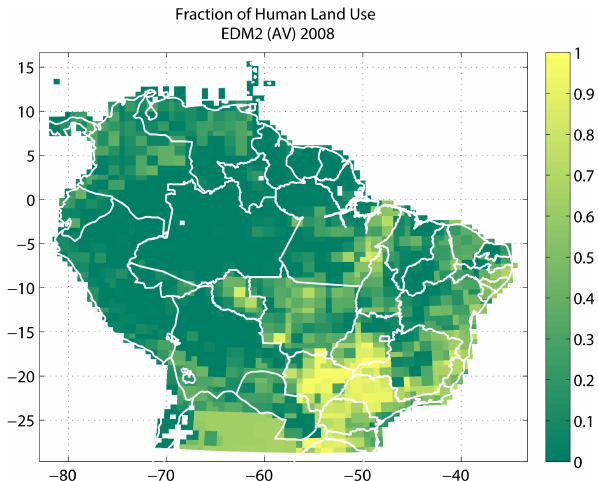
Figure 1. Fraction of the land surface with human land use. Output is taken from the ED2 the actual vegetation (AV) simulation, which was driven with global land-use (GLU) and SIMAMAZONIA-1- land-use transition